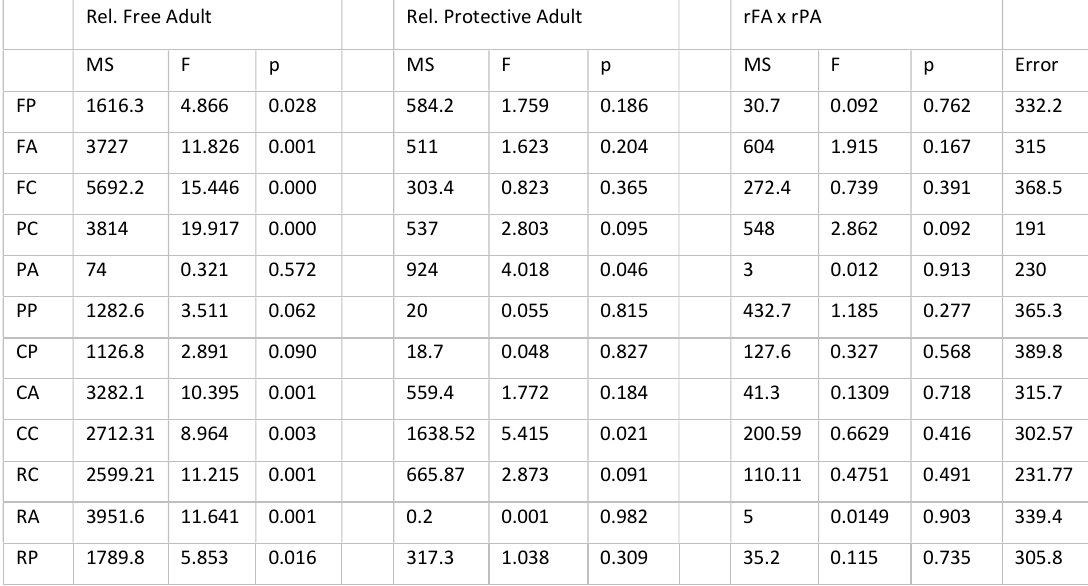
Table 6: Results of ANOVA for Relational Free Adult, Relational Protective Adult, and interaction of the two factors (significant p< .05 in bold